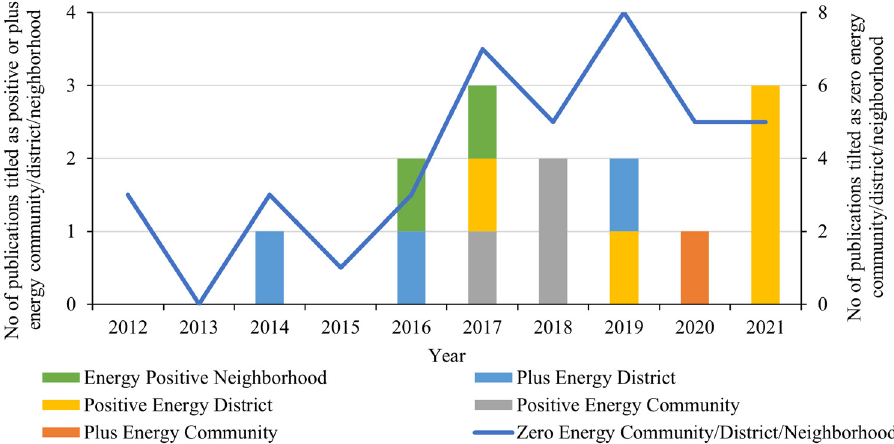
Figure 2. Comparison between the number of publications on zero and positive energy communities by year.